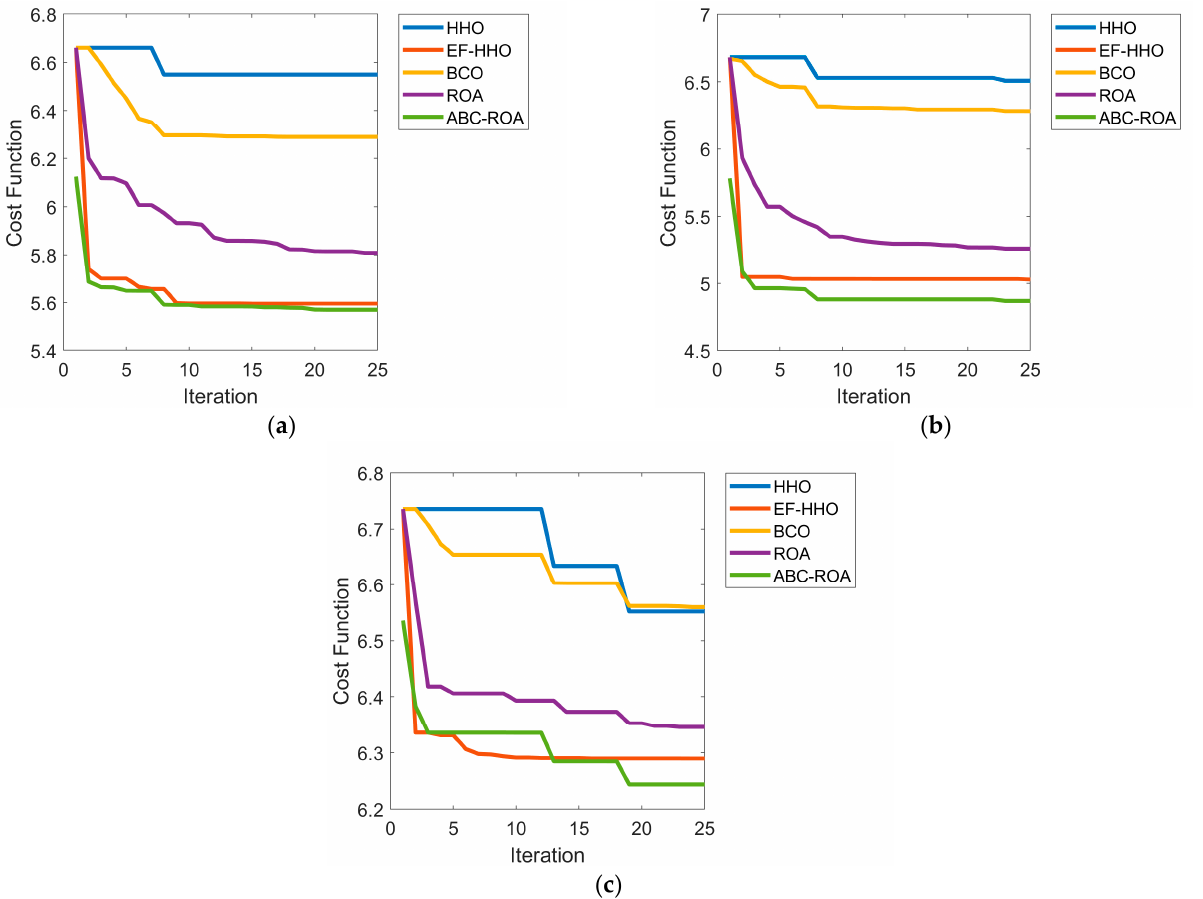
Figure 8. Convergence analysis on developed blockchain-based privacy preservation model in terms ( a ) dataset 1, ( b ) dataset 2, and ( c ) dataset 3.